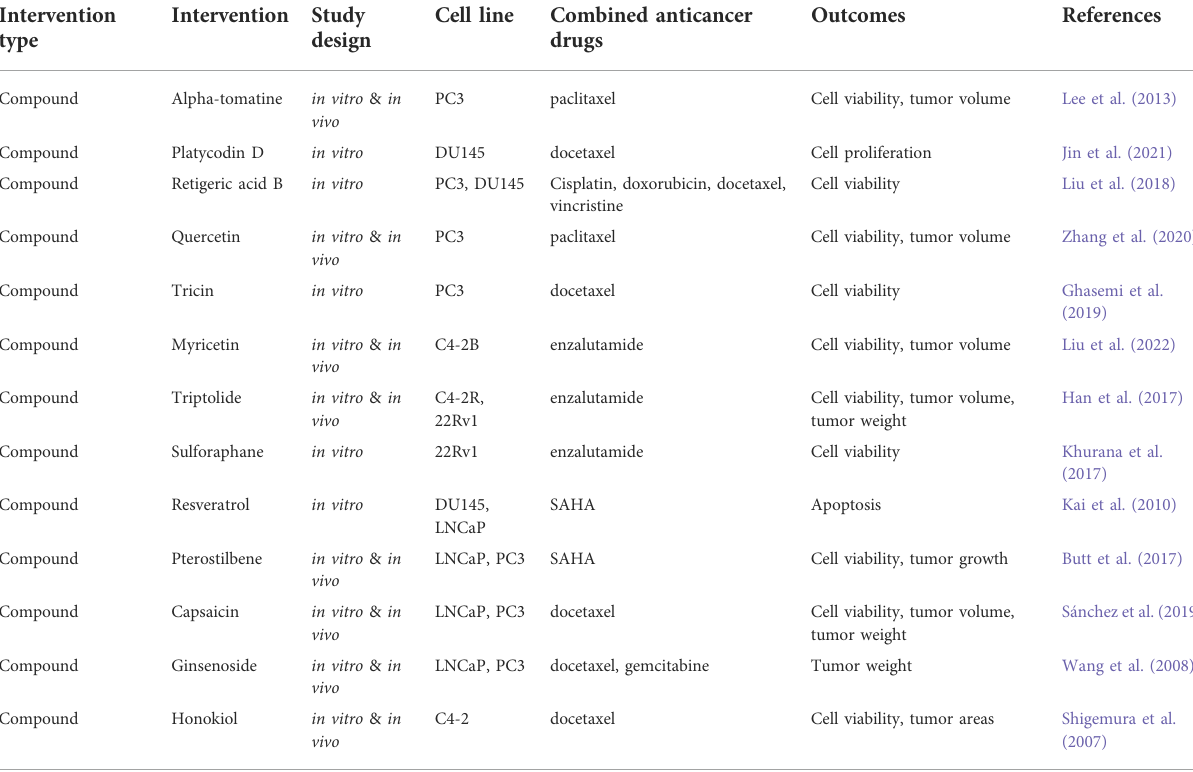
TABLE 2 Summary of studies using single active